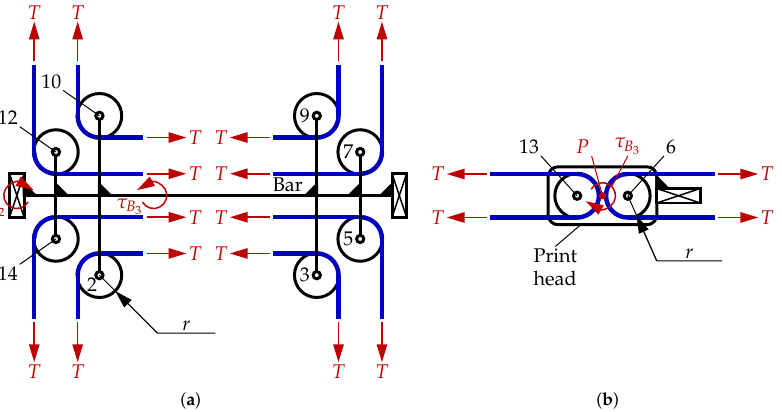
Figure 8. (a) : free-body diagram of the bar of the CoreH-bot, under static conditions; for clarity, the belt is “cut” in separate segments, to illustrate the force distribution. (b) : same, for the print head.